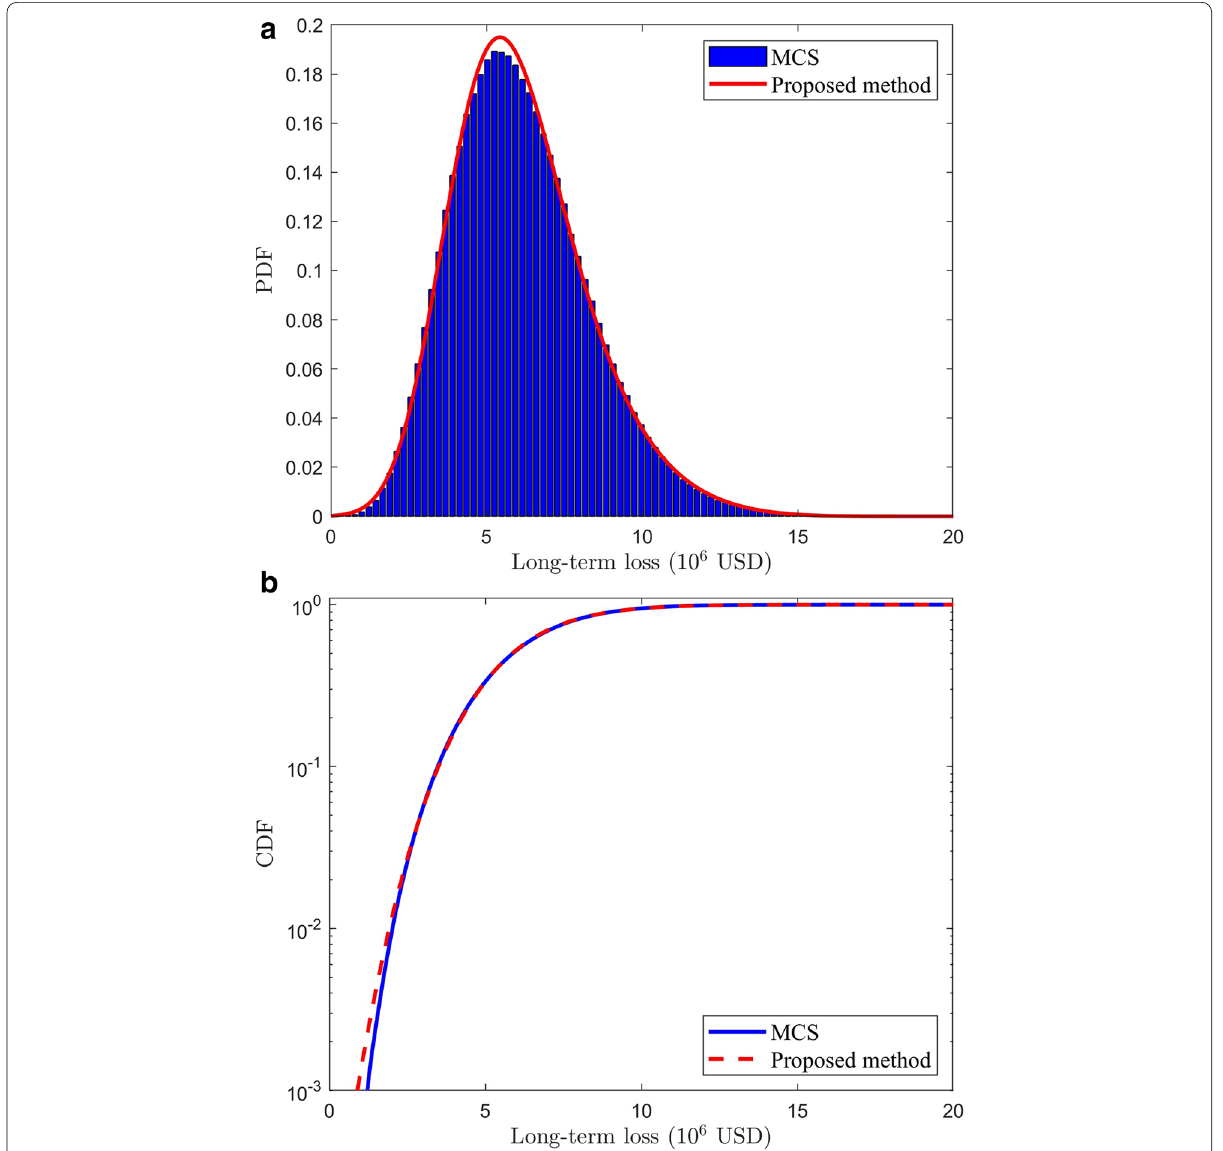
Fig. 3, different percentiles of long-term loss obtained